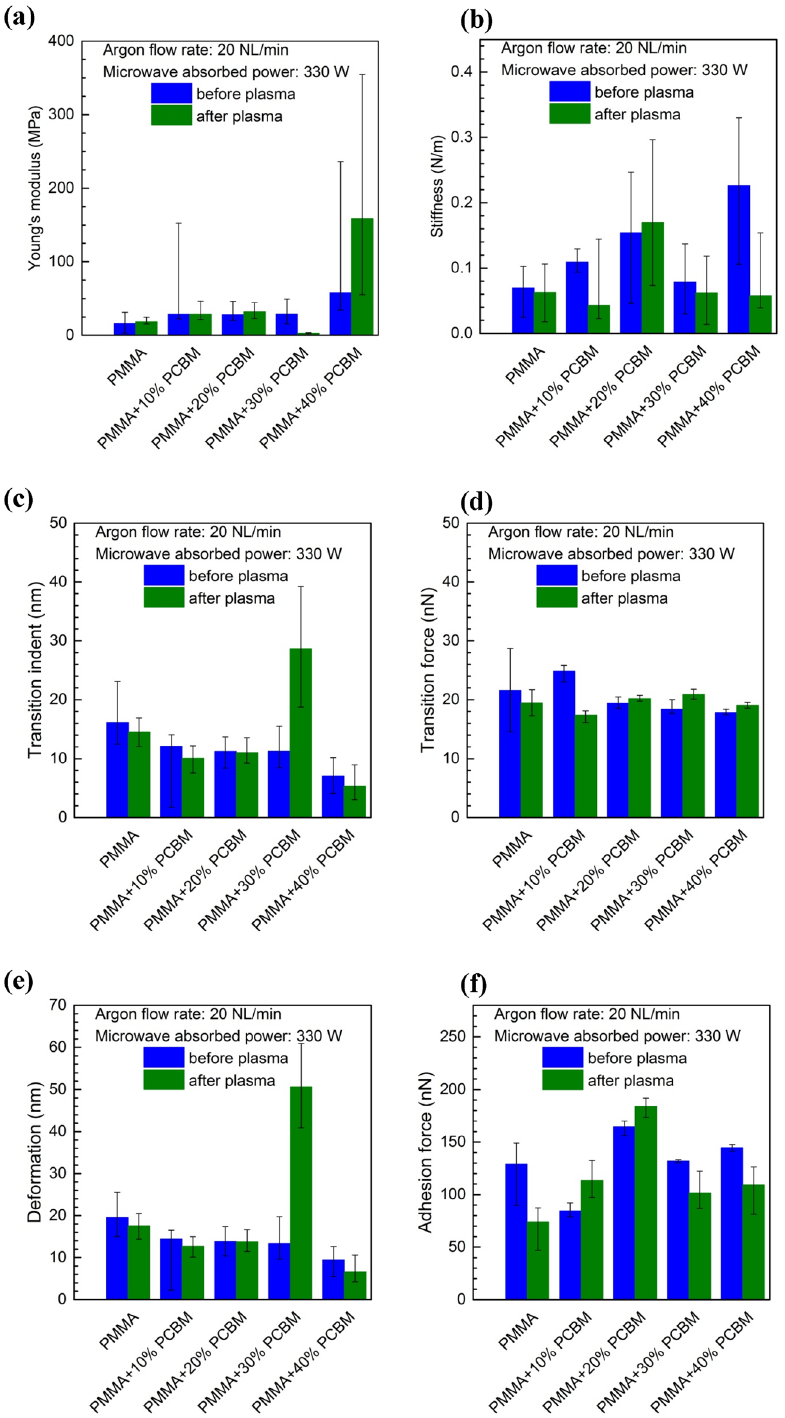
Figure 14. Effect of the plasma surface modification of PMMA polymer and PMMA + PC 61 BM composites on the surface mechanical properties parameters: ( a ) Young’s modulus; ( b ) stiffness; ( c ) transition indent; ( d ) transition force; ( e ) deformation; ( f ) adhesion force. Argon flow rate 20 NL/min. Microwave power 330